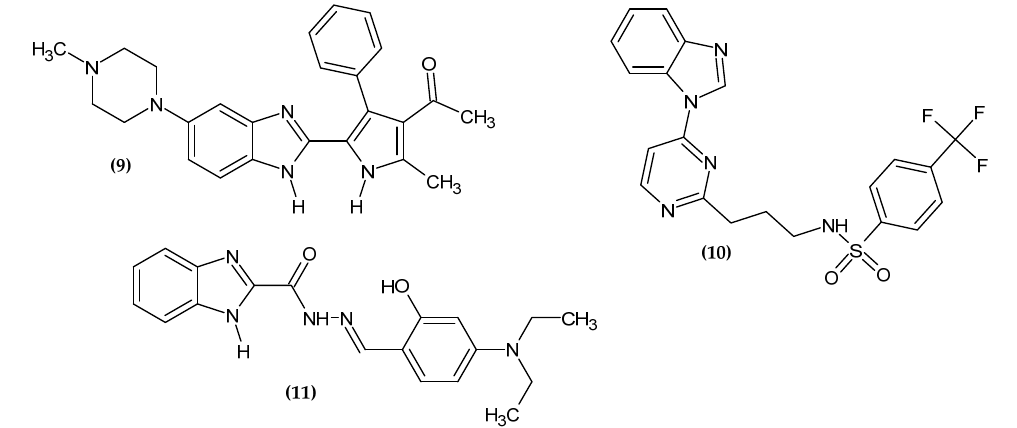
Figure 3. Benzimidazole derivatives with anti-melanoma